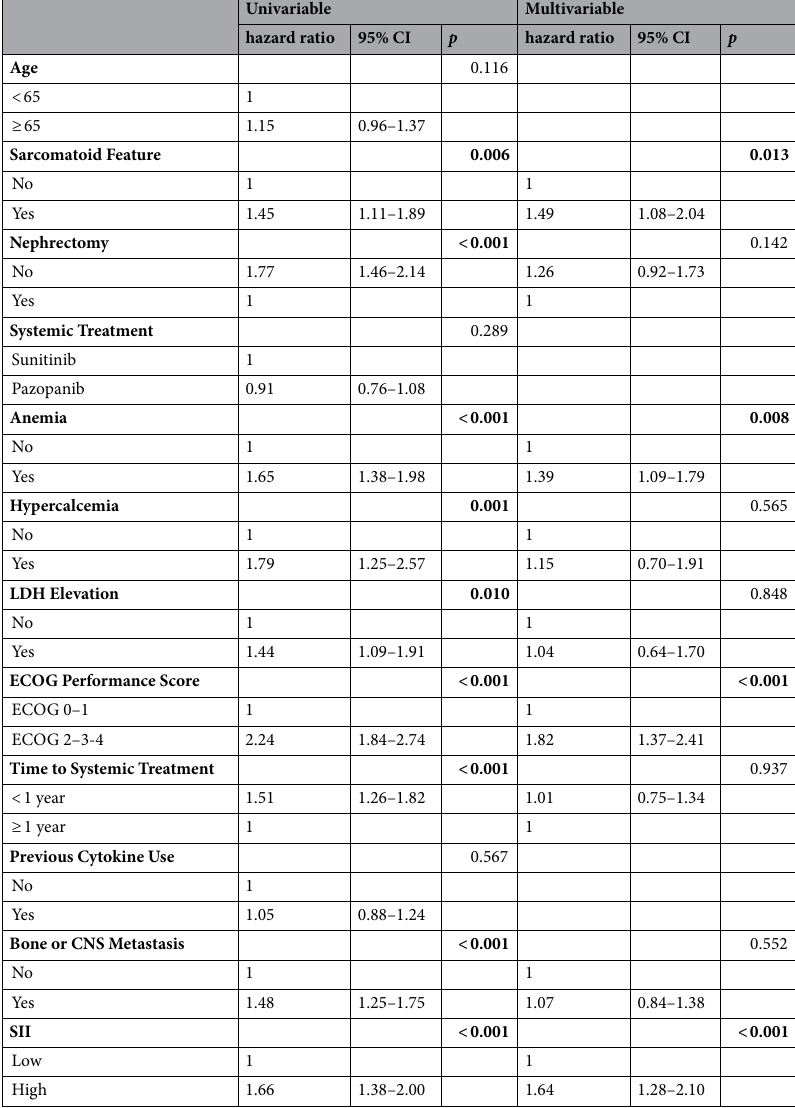
Table 3. Univariable and multivariable analysis of progression-free survival. CI confidence interval , CNS central nervous system , ECOG eastern cooperative oncology group , LDH lactate dehydrogenase , SII systemic immune-inflammation index. Significant values are in